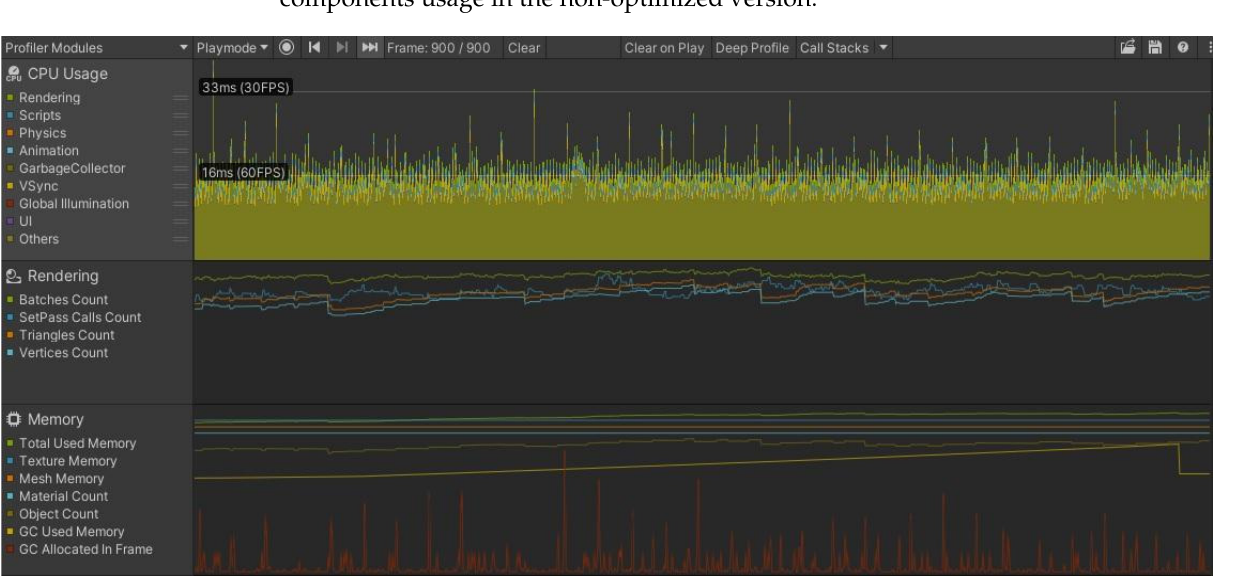
Figure 12. Profiler results for gameplay of the non-optimized version of the game.